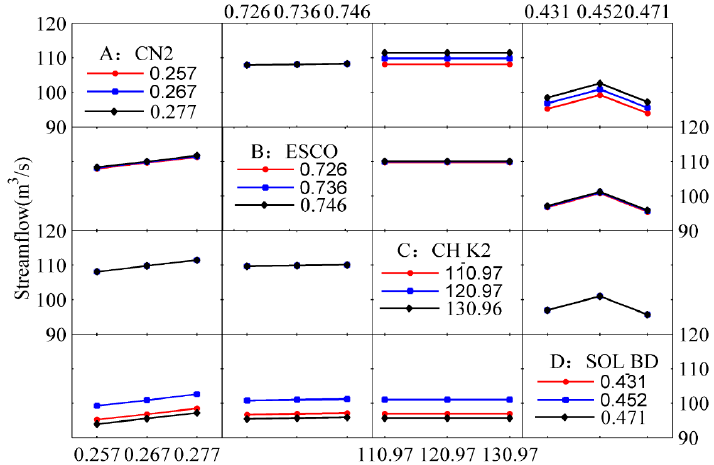
Figure 9. Interaction effects of parameters in the pre-flood period.